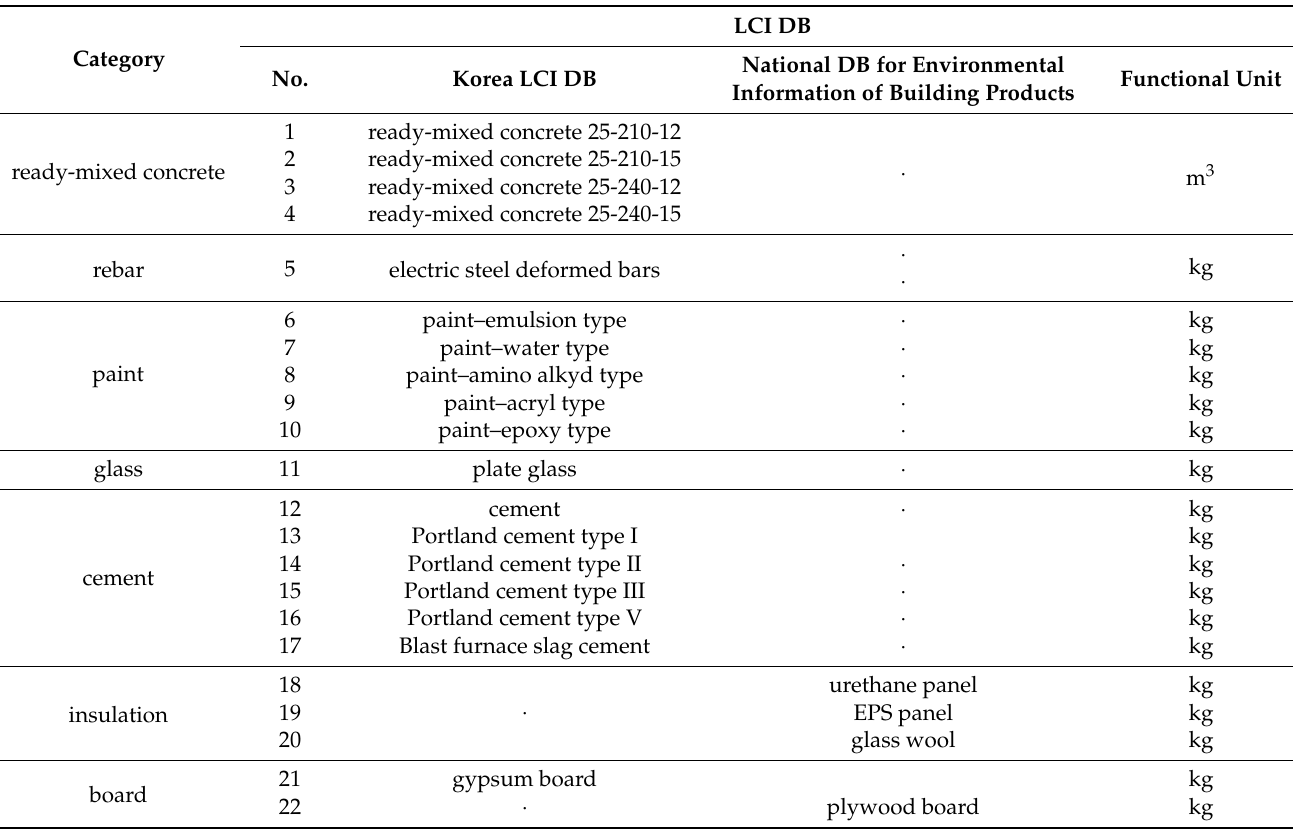
Table 2. Life cycle impact (LCI) database (DB) of construction